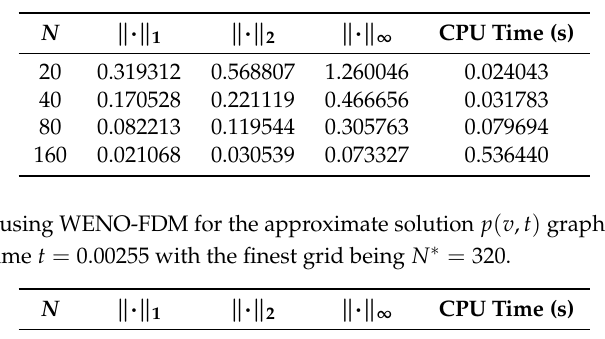
Table 5. Error table using FEM for the approximate solution p ( v , t ) graphically represented in Figure 4, at a final time t = 0.00255 with the finest grid being N ∗ = 320.